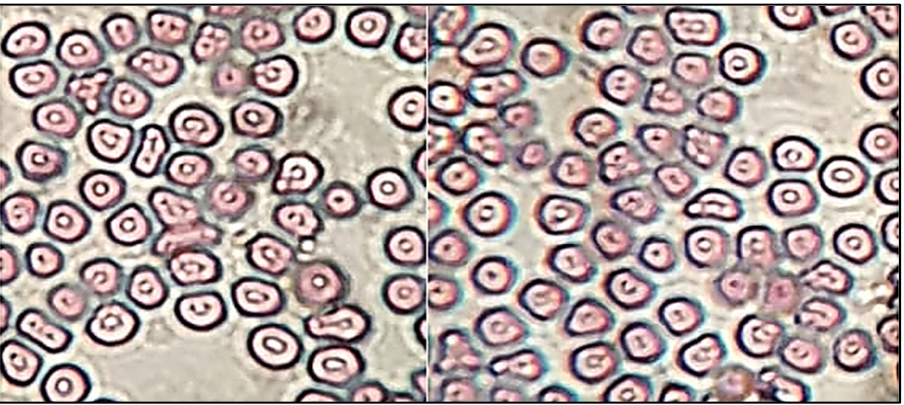
Figure 9. Isotonicity image of EM-NLCs-opt-IG4 and normal saline treated blood cells.